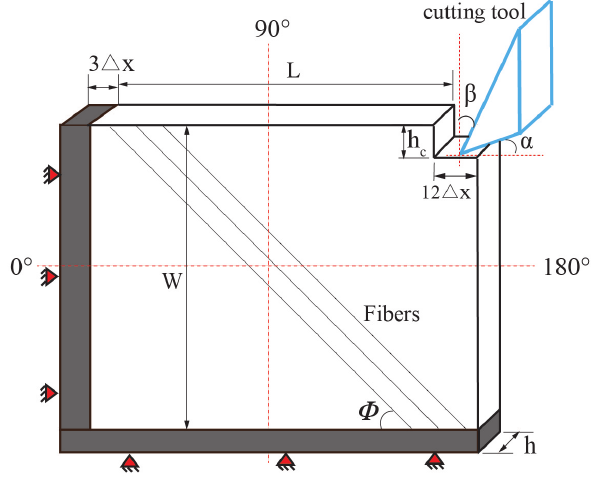
Figure 8. Schematic of simulation setup for CFRP orthogonal